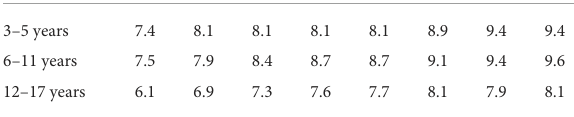
TABLE 6 Average number of MPH deliveries within 12 months of treatment initiation.